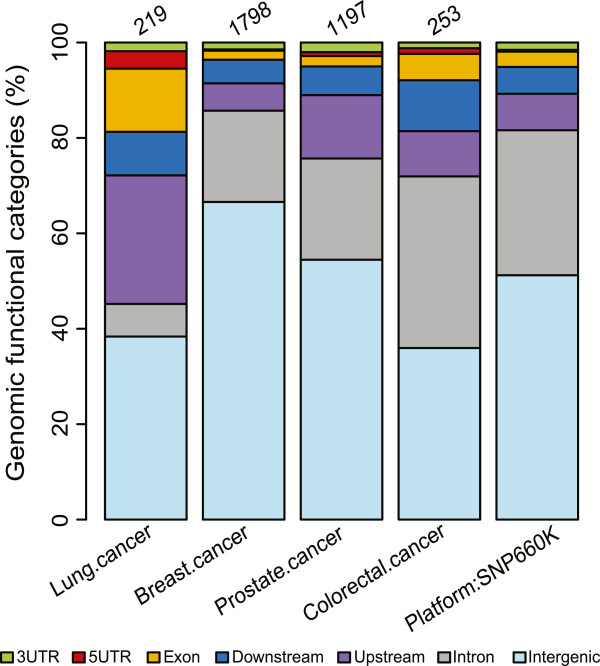
Distributions of genomic functional categories of cancer GWAS LD80 SNP sets. For each SNP in the corresponding GWAS LD80 SNP set, the genomic functional category was determined based on genomic annotation, and the overall proportions were shown in the plot. Categories included coding, 5′ untranslated and 3′ untranslated portions of exons, as well as intronic, intergenic and upstream or downstream proximals (within 10 kb of the TSSs or TTSs). The distribution of Illumina 660K SNP array was presented as a background. Numbers above the chart showed the corresponding total SNP counts of each LD80 SNP set.